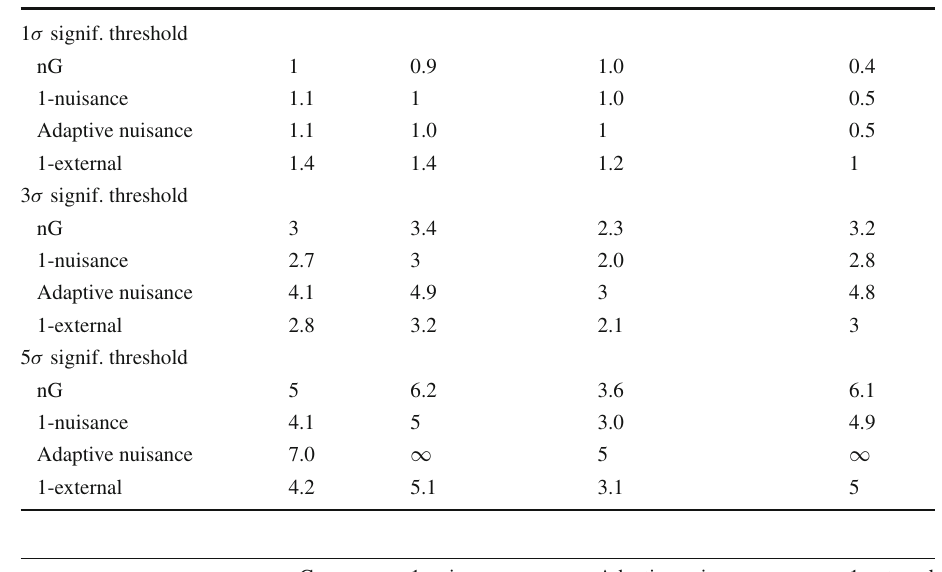
Table 4 Comparison of